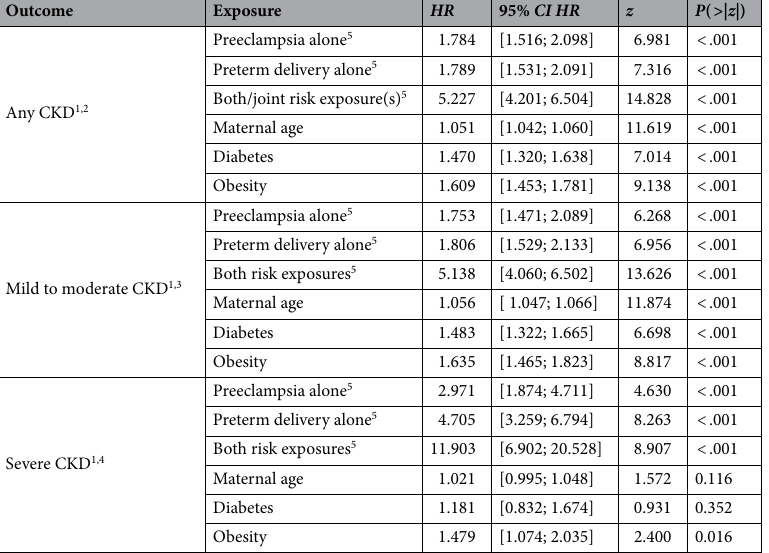
Table 3. Cox regressions for CKD by risk exposures. z = z -Value; P ( >| z |) = empirical significance level. CKD Chronic kidney disease, HR Hazard ratio, 95% CI HR 95% confidence interval of hazard ratio. 1 N = 257,481. 2 Number of events = 1.821. 3 Number of events = 1.577. 4 Number of events = 190. 5 Reference group = no exposure either to preterm delivery or to